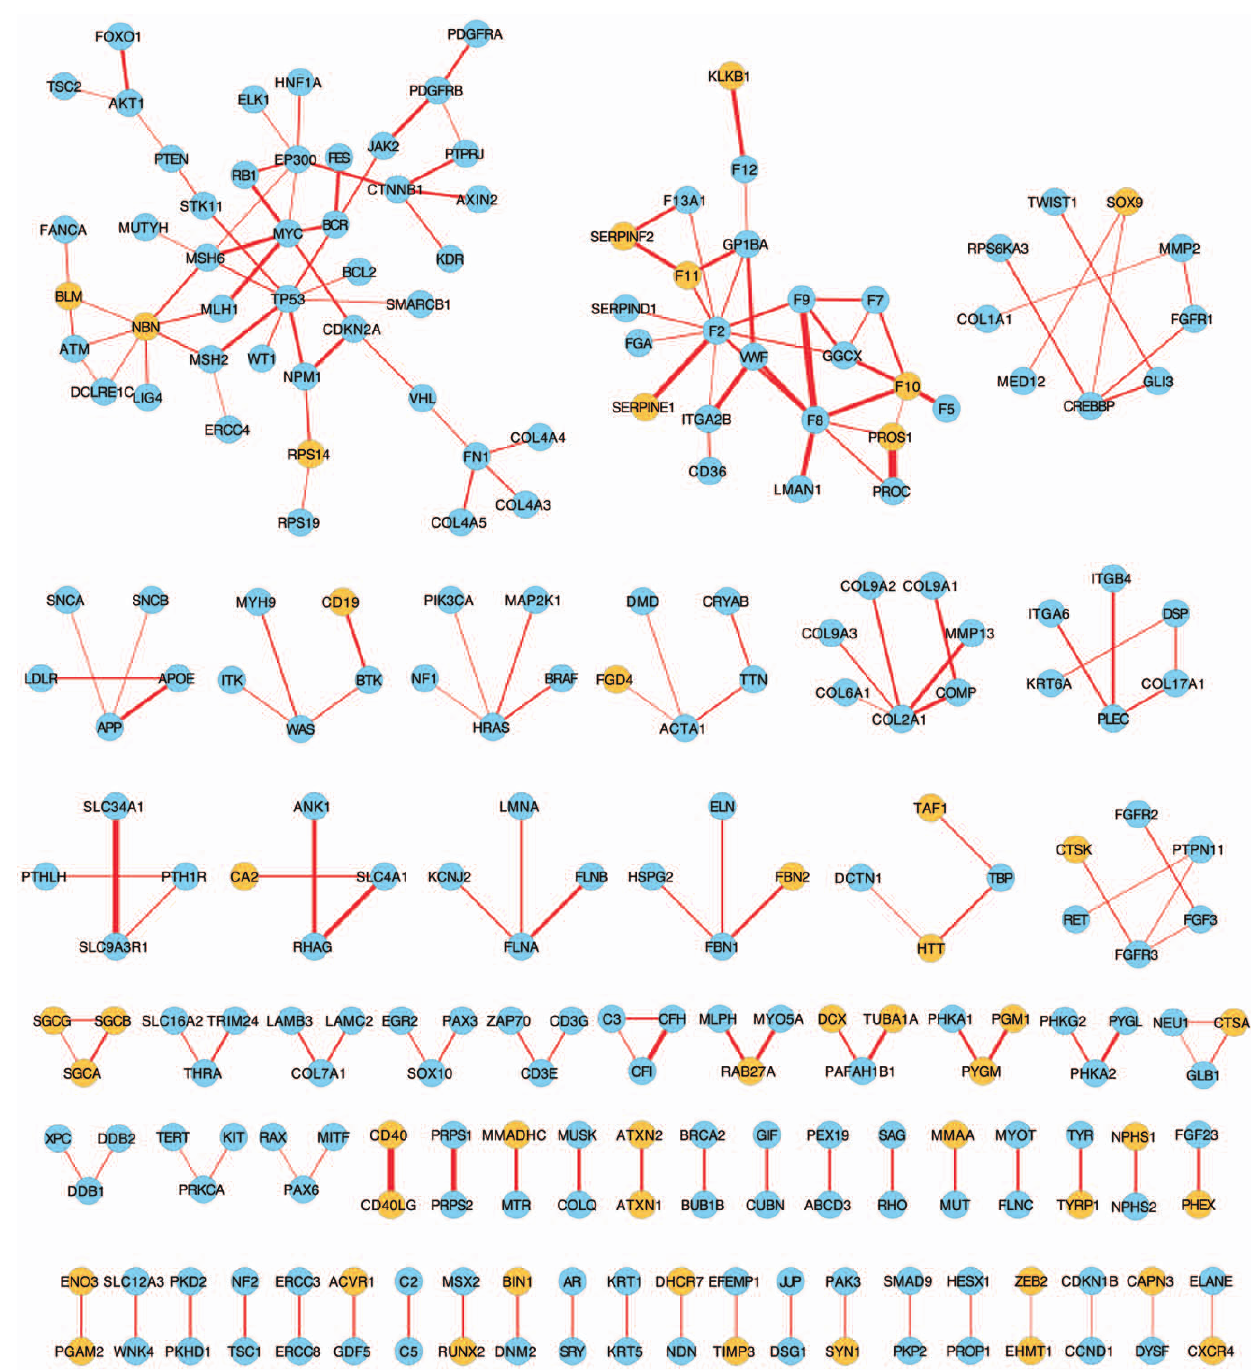
Figure 9. Physical interactions between genes with similar phenotypic lost in the current networks of diseases. This figure is the result of the difference of the resulting intersection between PSGN and PIN after removing those interactions present in HDGN and ODGN. Those genes that are MD-MG in HDN and ODN have been coloured in orangeThese genes indicate that they present underlying pathophenotypical relationships with other genes that had been disregarded by the inference of shared disease